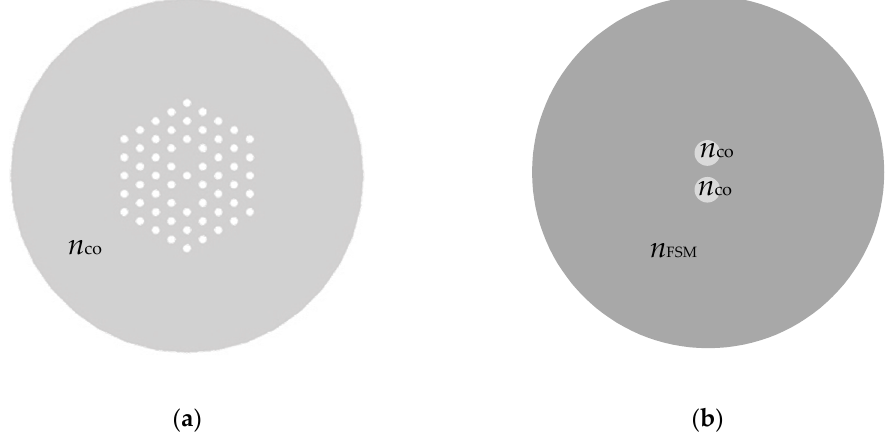
Figure 2. ( a ) Cross-section of ( a ) the simulated mPOF and ( b ) the equivalent dual-core step-index fiber. According to the theory, in the case of a DC SM mPOF, the fields in the fiber are well approximated by a linear combination of the fundamental-mode fields of each SM core in isolation. Coupling occurs as a consequence of the interference between those fields that cause an exchange of power between the cores as the light propagates along the fiber. More precisely, the power at each core is given